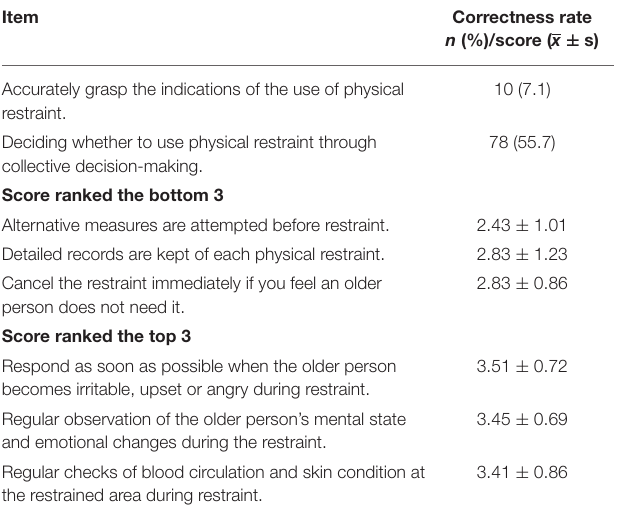
TABLE 3 | The scores of physical restraint practice ( N =